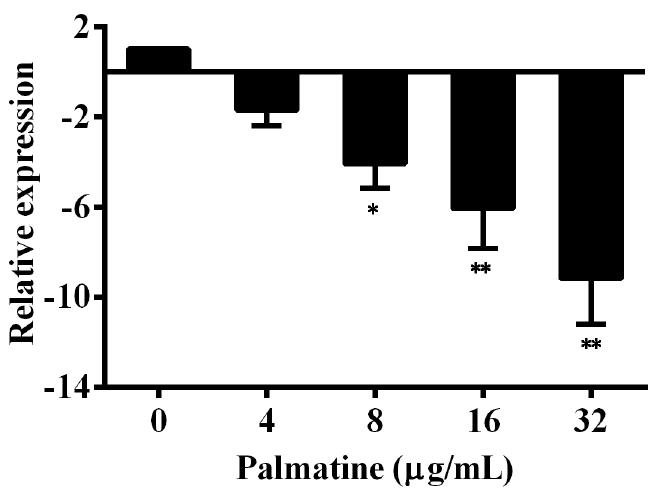
Figure 3. Impact of palmatine on the transcription of aerolysin-encoding gene aerA . Three independent assays were performed, and data are expressed as the mean ± SD; * indicates p < 0.05, ** indicates p < 0.01.